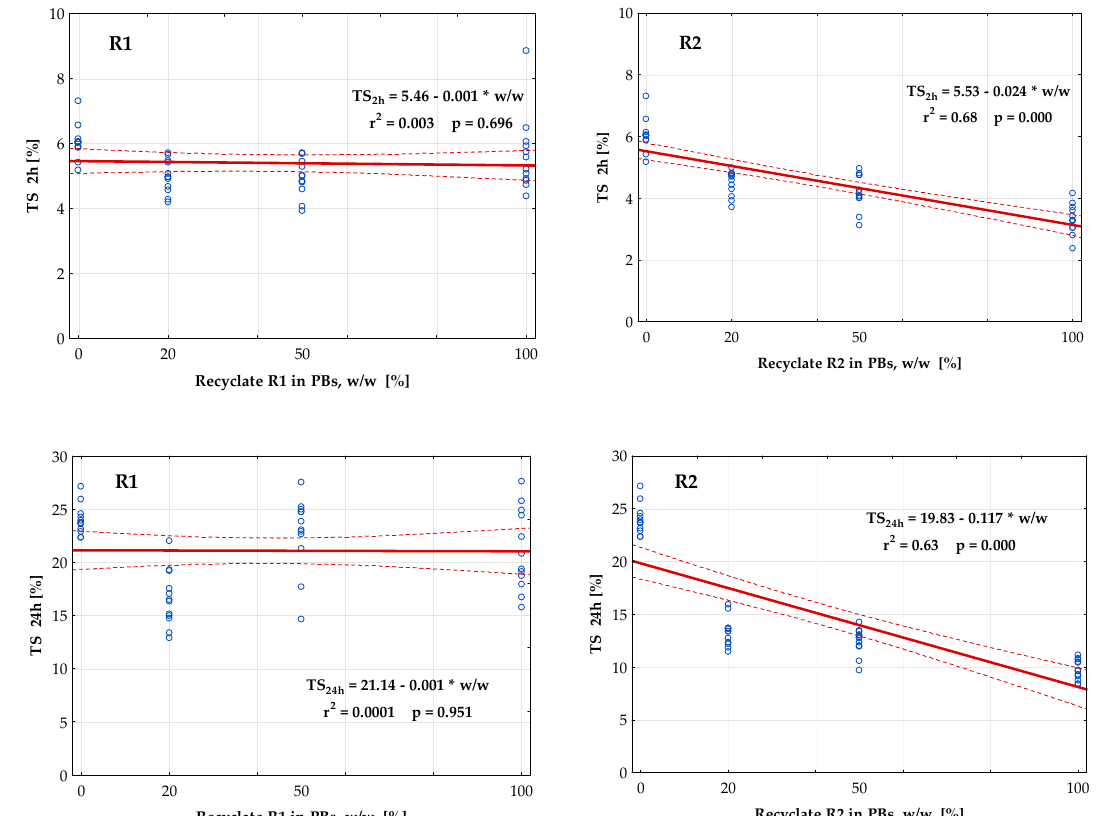
Figure 4. Thickness swelling (TS) after 2 and 24 h of PBs containing different types (R1 or R2) and amounts of wood recyclates.